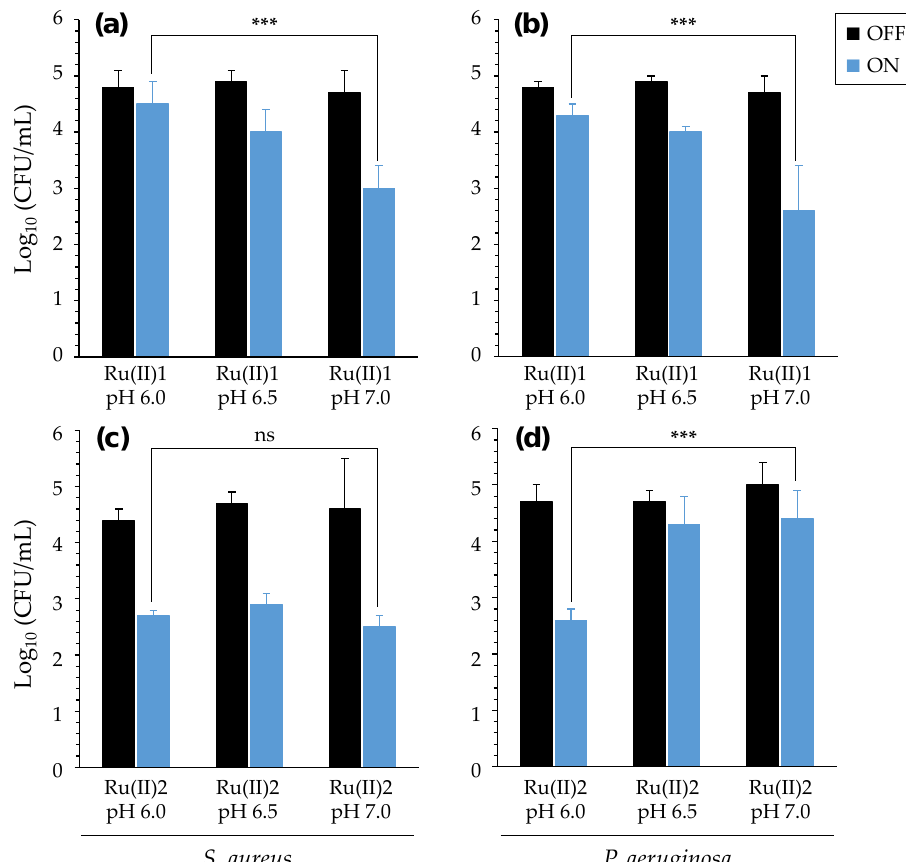
Figure 6. PDT effects of [Ru(II)] at various pH. Results were obtained using [Ru(II)]1 ( a , b ) or [Ru(II)]2 ( c , d ) with S. aureus RN4220 ( a , c ) and P. aeruginosa PA19660 ( b , d ). [Ru(II)] concentration was adapted to each strain evaluated: [Ru(II)]1 was 40 and 10 µM, whereas [Ru(II)]2 was 0.1 and 1 µM in acetate buffers, when assaying S. aureus and P. aeruginosa , respectively. Mean ± SD with n = 3 and N = 2. ***, p - value ≤ 0.001; “ns”: non -significant.